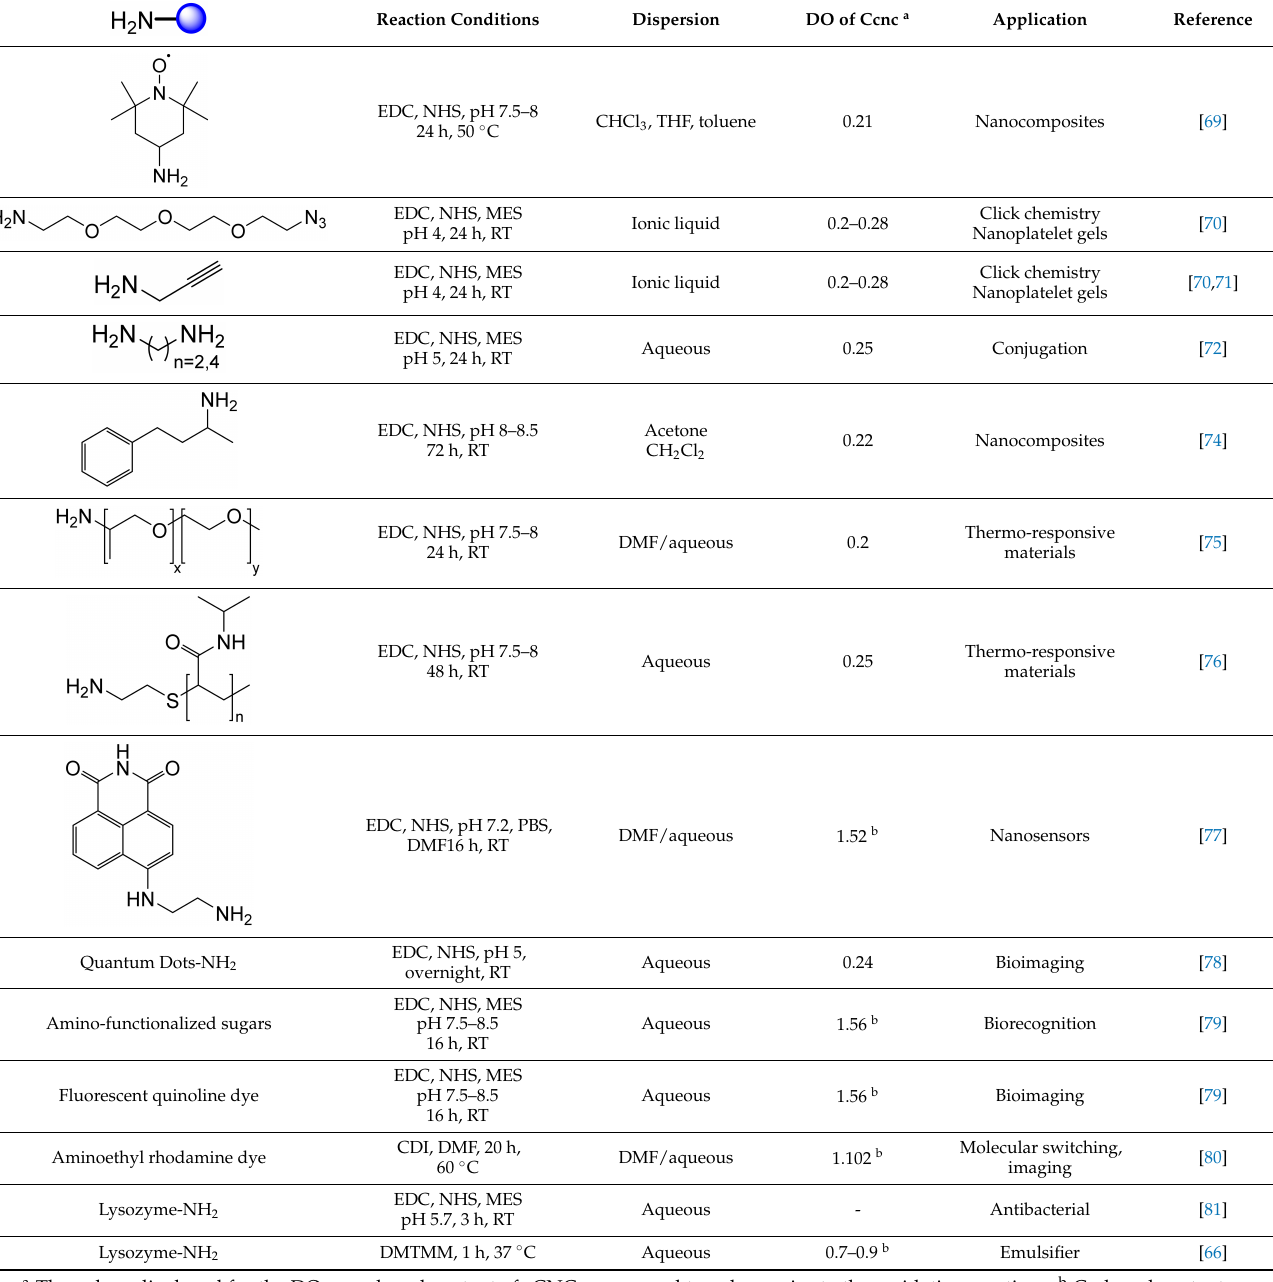
Table 2. Amidation reactions on cCNCs for the design of functionalized CNCs in various